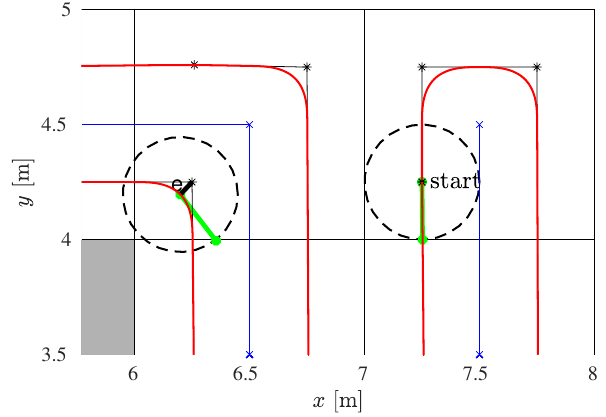
Figure 5. The enlarged part of the coverage path with two positions of the robot: (1) the robot’s starting position and (2) the robot’s position at the obstacle corner. The obstacle cell is shown in gray, the robot’s positions in dashed circles, the robot’s orientation in green, the spanning tree in blue, the RSTC path in black, and the smoothed path in